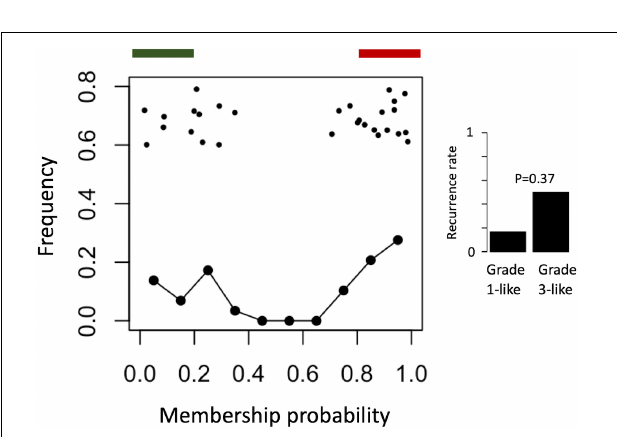
FIGURE 3 | Validation of meningioma reclassification using RNA-seq data. Summary graph of fuzzy C-means clustering best performing inputs on the microarray data (modules RB + T). The x -axis represents the probability of being in the grade-3 enriched cluster and y -axis represents the proportion of patients in each bin of 10%. Line graph component represents normalized frequency distribution of each histological grade (green = grade 1, black = grade 2, red = grade 3). Top jitter plot represents individual patients. Dark green and red bars above represent the 20 and 80% thresholding into grade 1-like and grade 3-like subgroups of grade 2 meningiomas. Recurrence rates are plotted on the right by grade and subgroup (“grade 1-like” and “grade 3-like”). Notably, recurrence data is not available for the grade 3 meningiomas in this